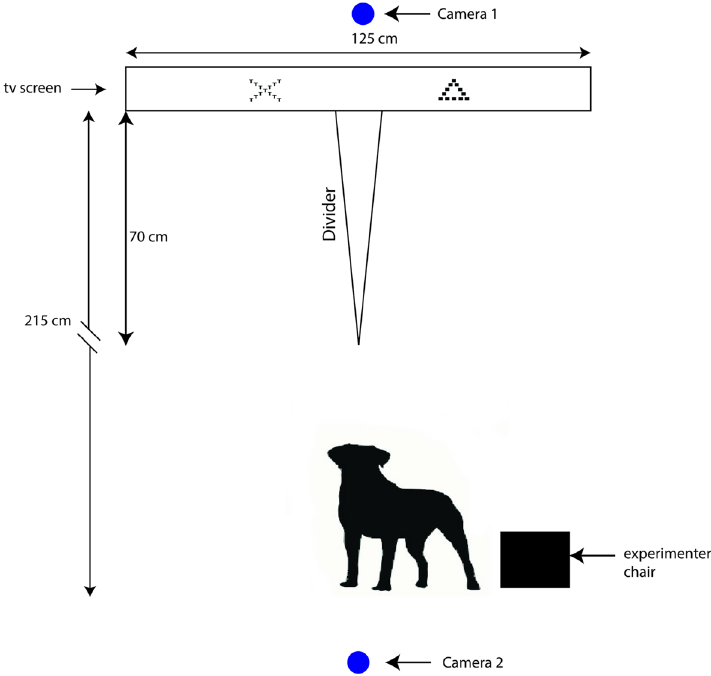
Figure 3. Experimental set-up to assess attentional scope. Dog vector from